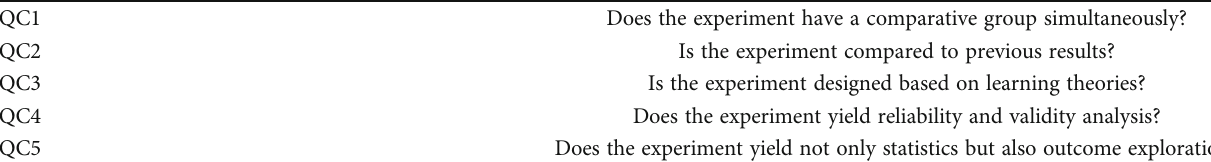
Table 2: Quality